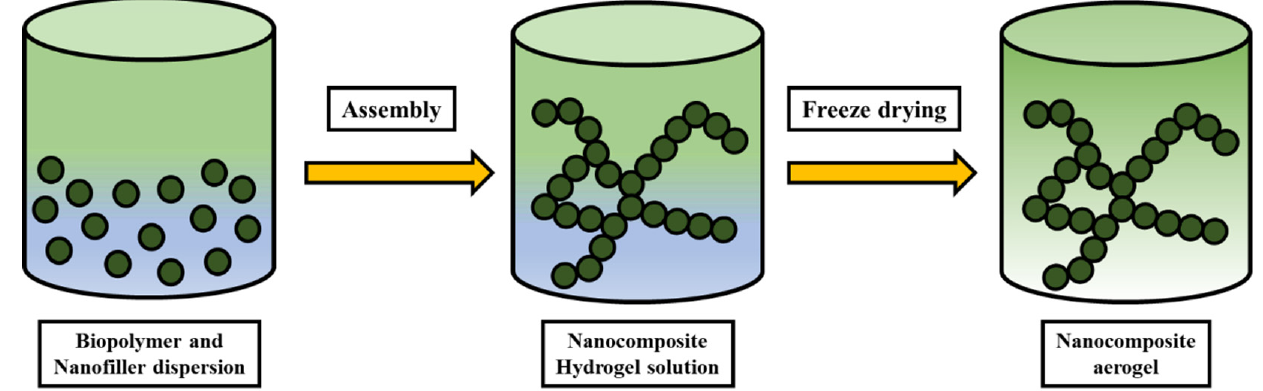
Figure 7. Freeze drying process for nanocomposite preparation.